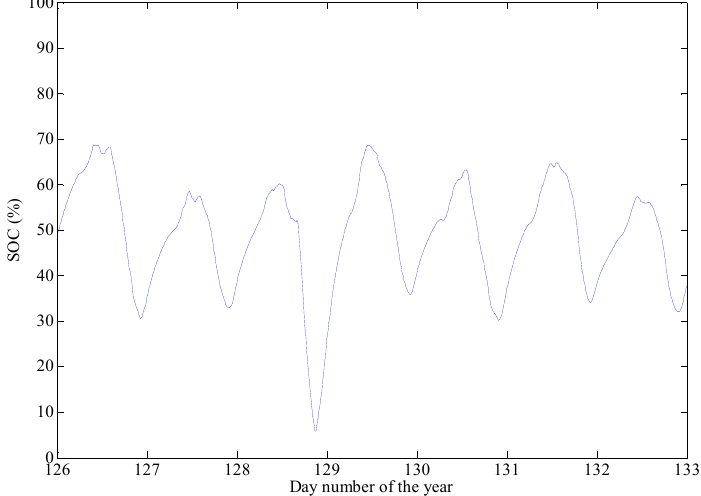
Figure 6. Evolution of the useful SOC during the Week 19.